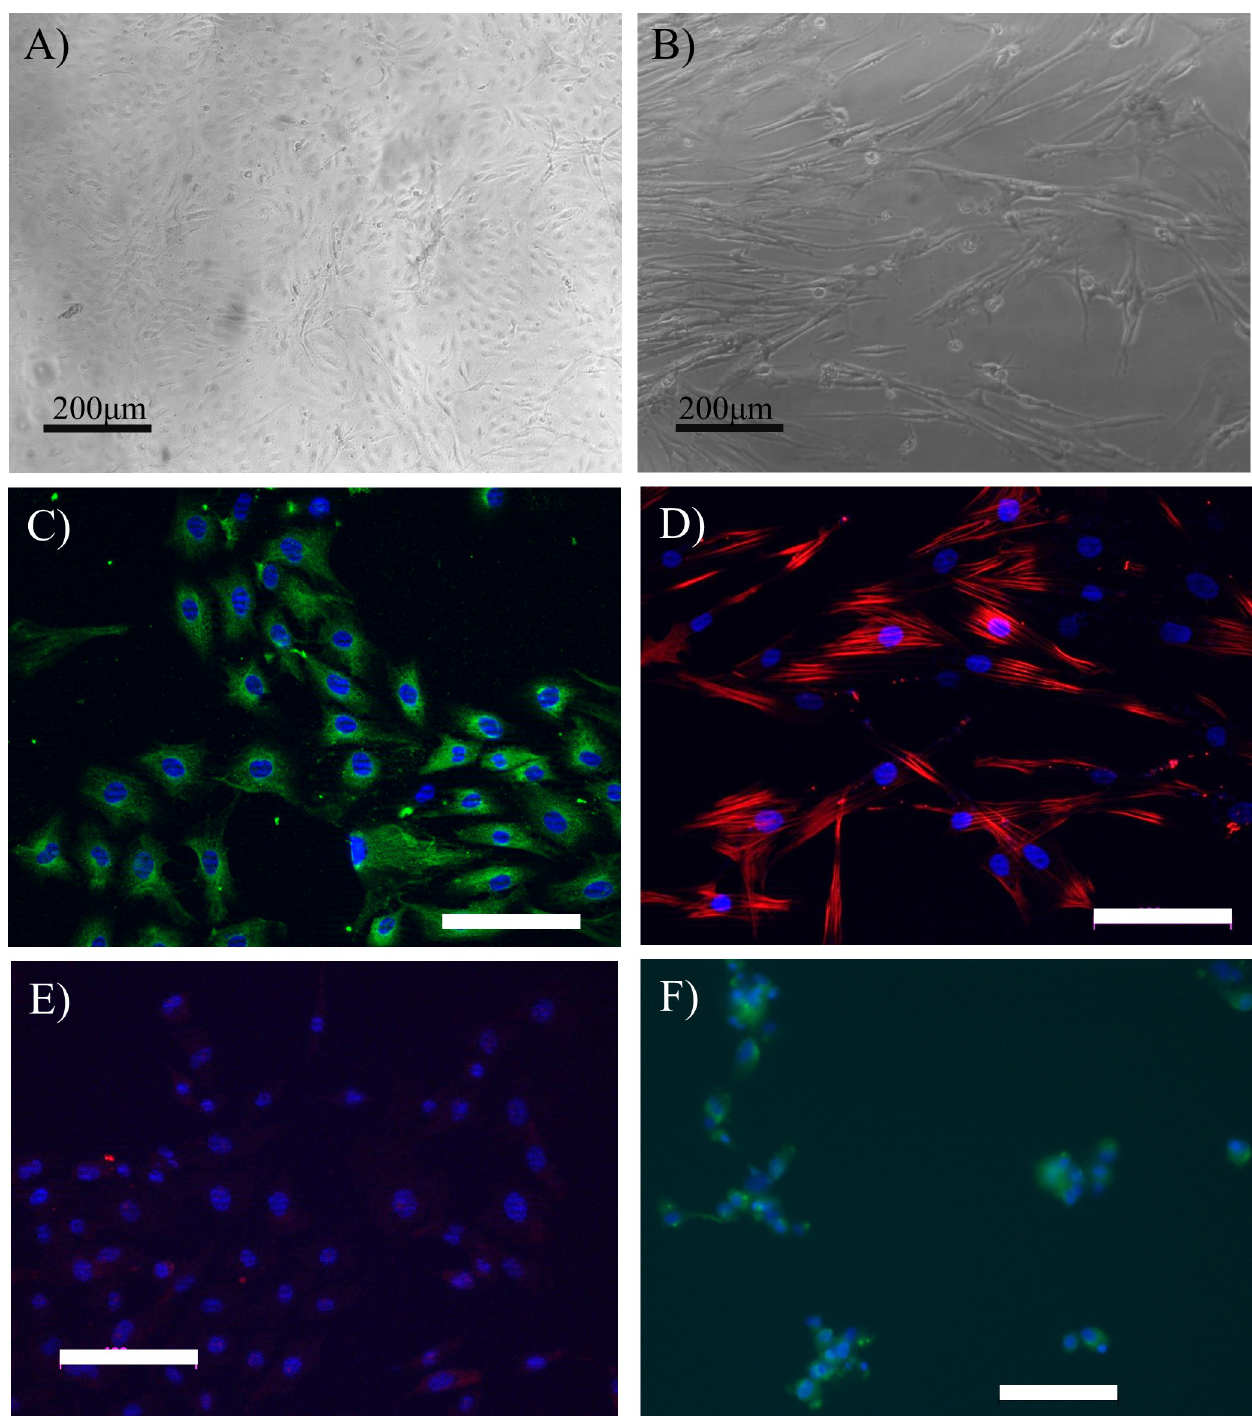
Fig 2. Primary cell isolation light microscopy and immunofluorescence characterisation. Light microscopy images showing typical morphologies for (A) isolated ECs and (B) SMCs. (C) ECs positively stained for the marker Von Willebrand factor (green). (D) Smooth muscle cells positively stained for alpha smooth muscle actin (red). (E) Negative control, ECs showing minimal staining for alpha smooth muscle actin (red). (F) Negative control, SMCs showing minimal staining for Von Willebrand factor (green). Images were taken of cells at passage 2. White scale bars are 100 μ m, all nuclei stained with DAPI (blue).